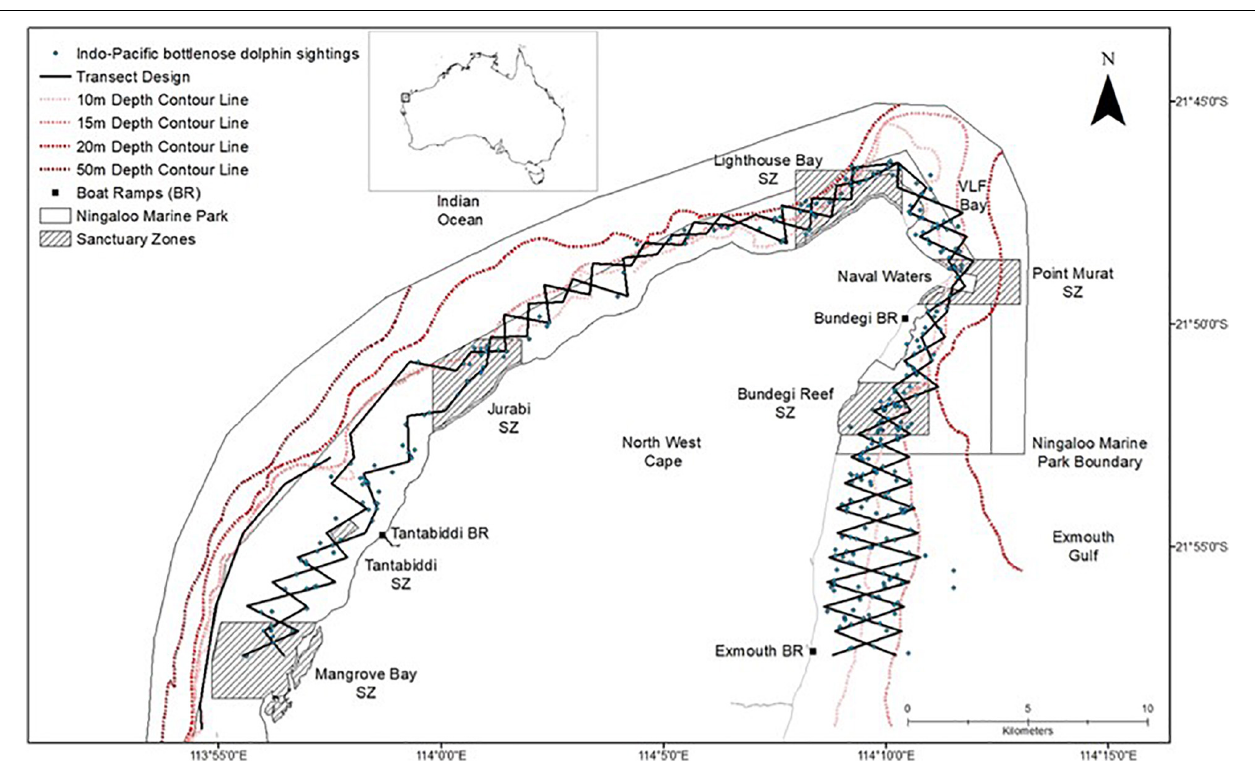
FIGURE 2 | Map of the North West Cape (NWC) study site in Western Australia (WA) including transect layout and Indo-Pacific bottlenose dolphin sightings ( n = 323) encountered between 2013–2015 and